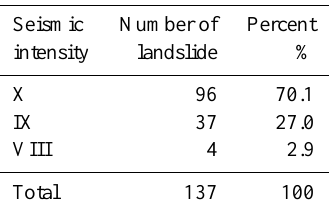
Table 4. Distribution of landslides by slope angle (from Institute of Geography of Sichuan province).